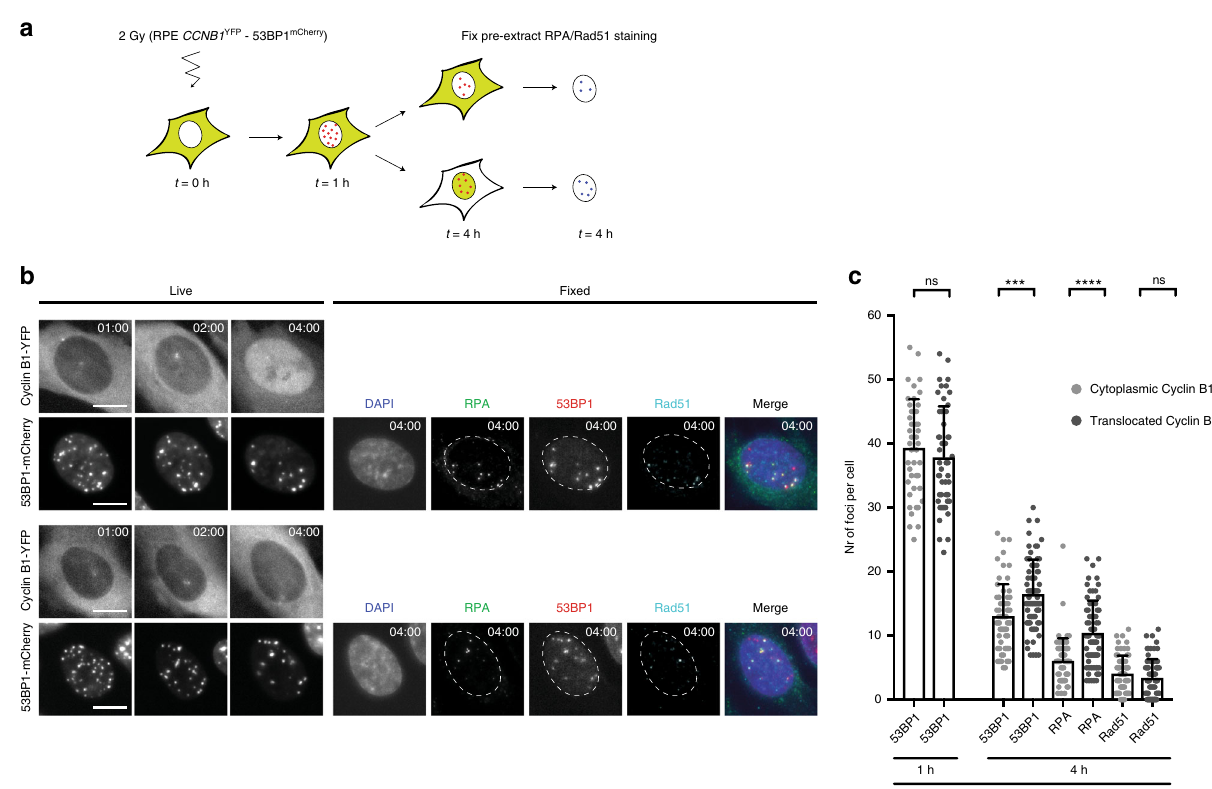
Fig. 4 Ef fi cient processing of DNA lesions is necessary to prevent cell cycle exit. a Schematic representation of the experimental set-up. b Stills represent RPE CCNB1 YFP cells with 53BP1 mCherry tracked by live-cell imaging at indicated timepoints after IR (2 Gy) followed by an image of the identical cell that was fi xed 4 h after IR and stained for RPA and Rad51. Scale bar 10 μ m. c Number of indicated foci in cells that have cytoplasmic Cyclin B1 localization at 4 h after IR (2 Gy) or cells that translocated Cyclin B1 and therefore have nuclear localization at 4 h after IR. 53BP1 foci were determined at indicated timepoints by live-cell imaging of RPE CCNB1 YFP -53BP1 mCherry cells. RPA and Rad51 foci were determined in the tracked cell by imaging of the same position after fi xation, pre-extraction and antibody staining for RPA and Rad51. Pooled cells from three independent experiments. n > 65 +